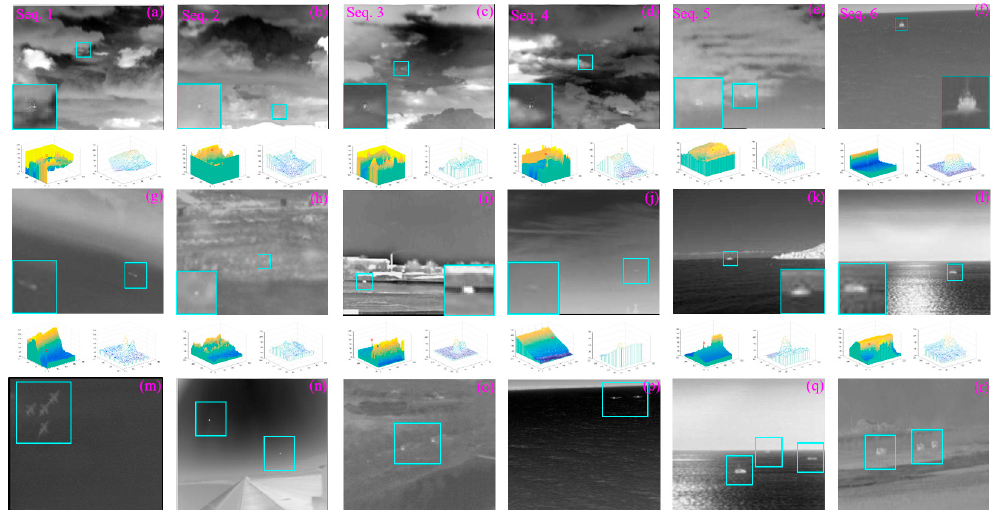
Figure 5. Original infrared small target scenes under various scenes for experiments. ( a – l ) Infrared images with single small target. ( m – r ) Infrared images with multiple targets.